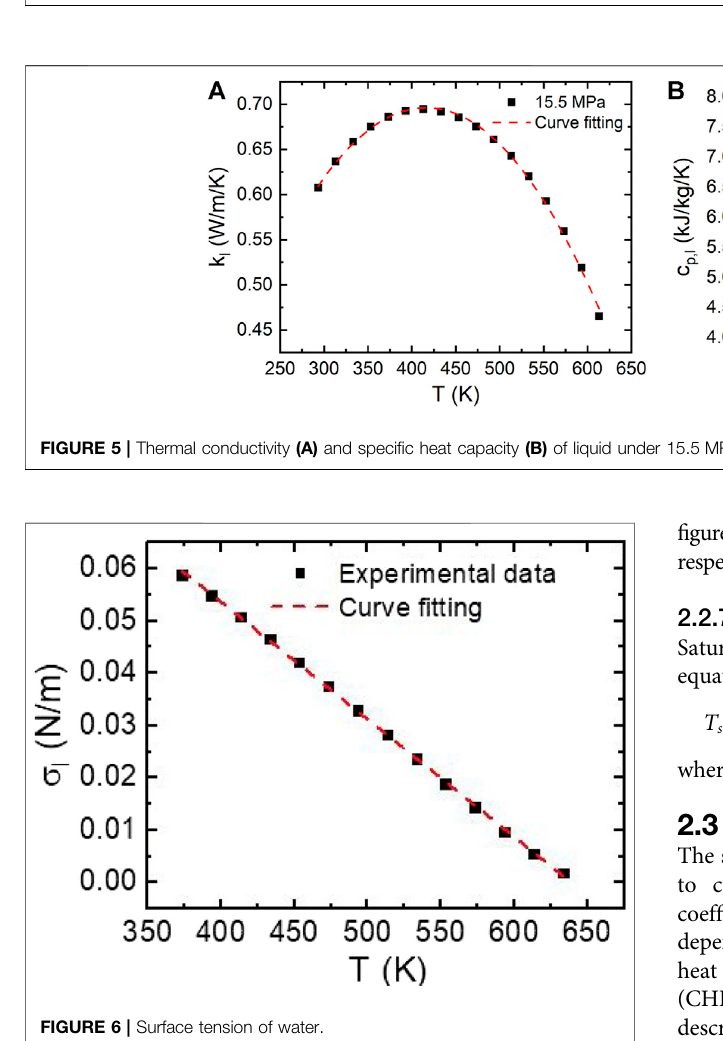
FIGURE 4 | Density of liquid under 15.5 MPa (A) and saturated vapor (B) .